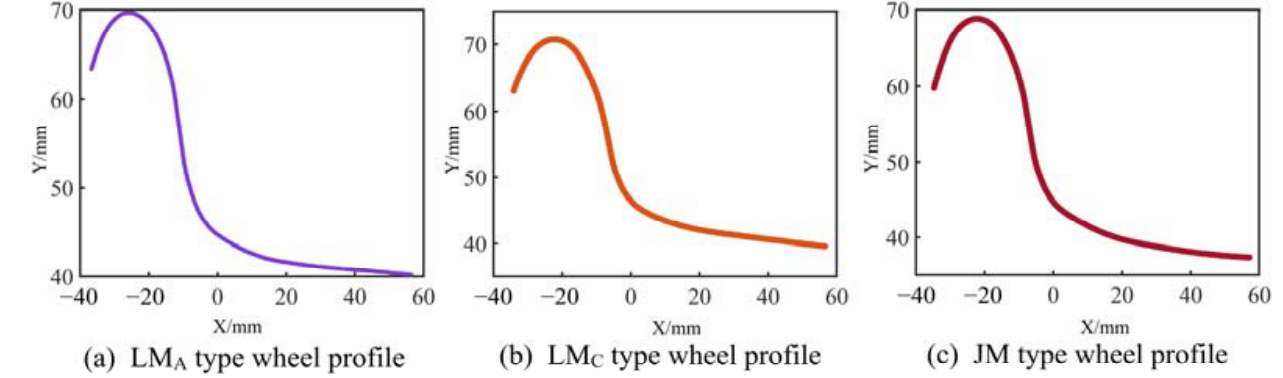
Figure 7. Different types of wheel profiles.